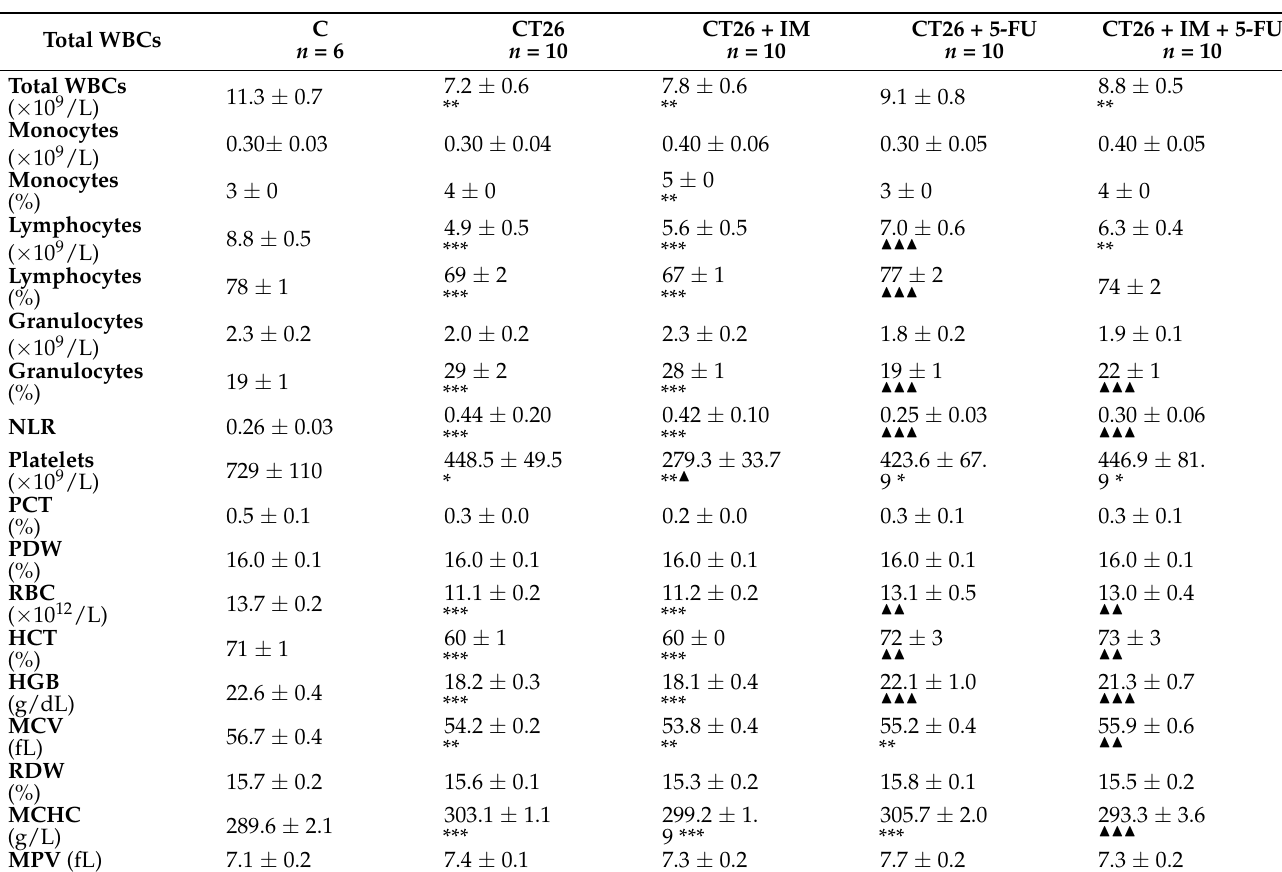
Table 1. The effect of treatments on hematological parameters in